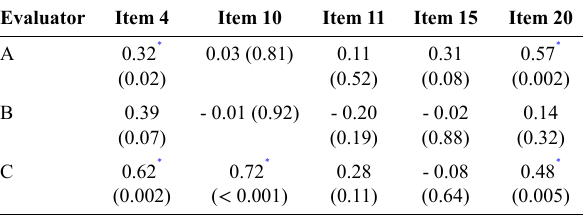
Table 4 - Intra-rater reliability from the five items checklist and its movement descriptors (MD) of the high upper limb in front crawl pro- posed in the third